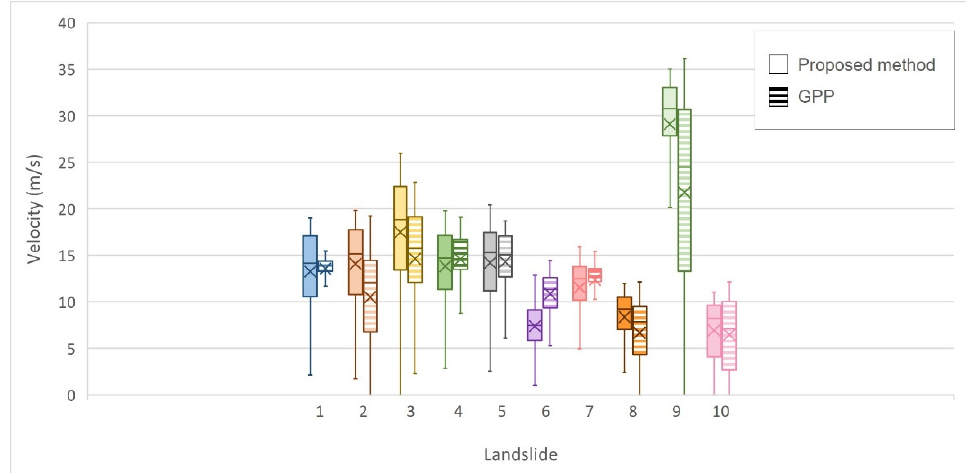
Figure 12. Boxplots of the velocity values of the selected sample of rockfalls. The full-colour boxplots refer to the proposed method velocity values, and the dashed ones to the GPP velocity values. The colours correspond to those used in Figure 10. The boxplot consists of a box, delimited by the first and third quartiles, with the median value reported inside, and two whiskers that connect the box to the minimum and maximum value.